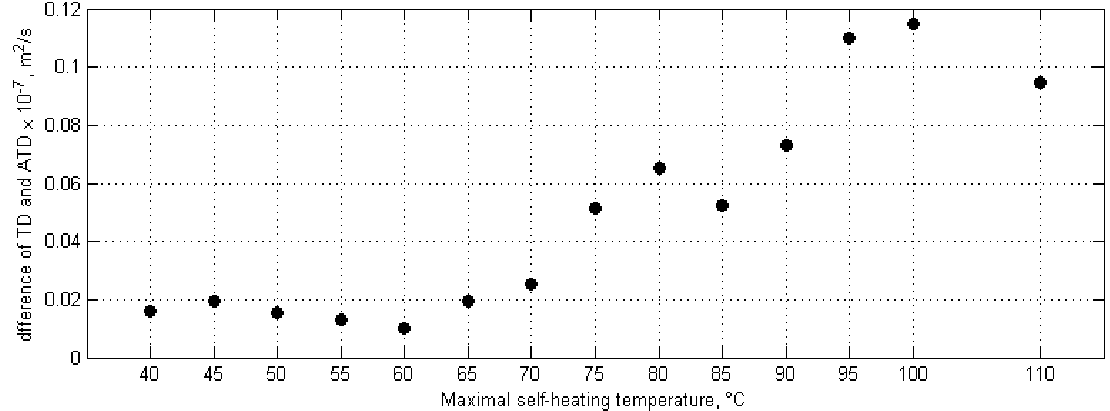
Figure 9. Relative apparent thermal diffusivity (ATD) for various self-heating temperature values.